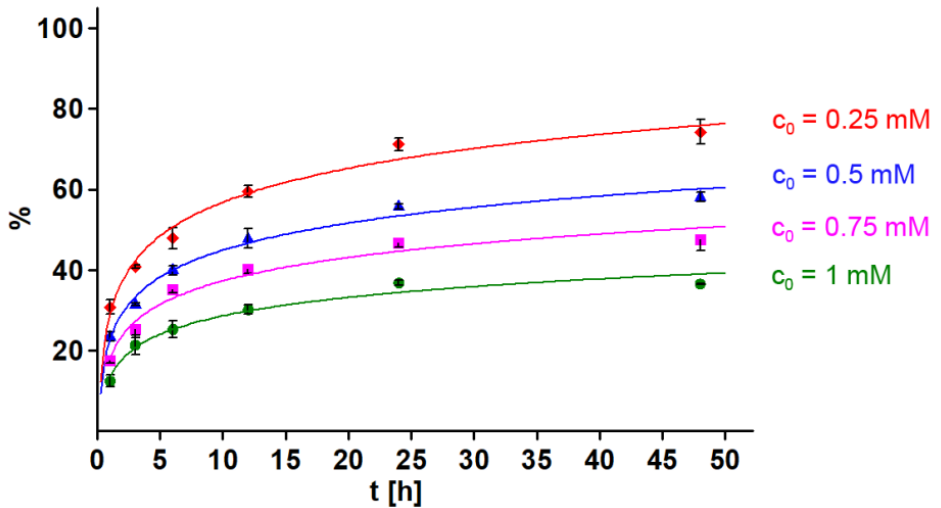
Figure 8. Effect of incubation time and initial meloxicam concentration (C 0 ) on the amount of drug bound to DOPA-melanin (in %).